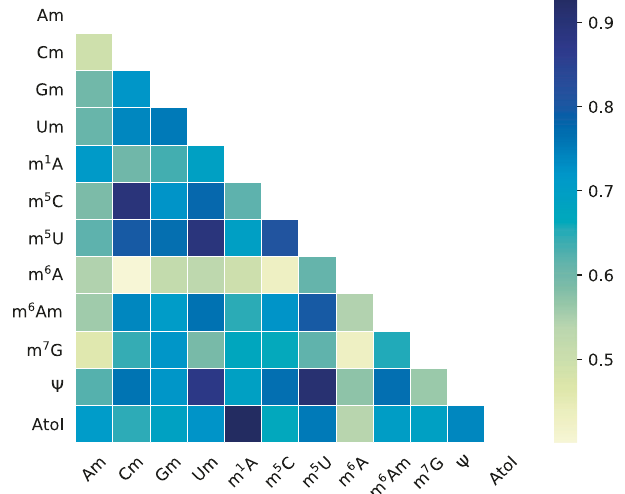
Fig. 3 Association of RNA modi fi cations revealed by MultiRM. The RNA modi fi cations considered in MultiRM all show positive relationships among one another, suggesting that there are some regions intensively modi fi ed by multiple RNA modi fi cations, which are likely to be key regulatory components for the epi-transcriptome layer of gene regulation. Modi fi cations on the same nucleotide are likely to be more strongly associated with each other, such as m 5 C and Cm ( ρ = 0.895, p -value = 3.81E − 36), I and m 1 A ( ρ = 0.931, p -value = 9.57E − 45), Ψ and m 5 U ( ρ = 0.908, p -value = 5.47E − 39). The two-sided Pearson correlation test was performed using the exact distribution of the sample correlation coef fi cient. Statistical signi fi cance was calculated by the probability that abs( ρ ′ ) of a random sample x ′ and y ′ drawn from the population with zero correlation would be greater than or equal to abs( ρ ). The weights used to generate this fi gure can be found in GitHub ’ s